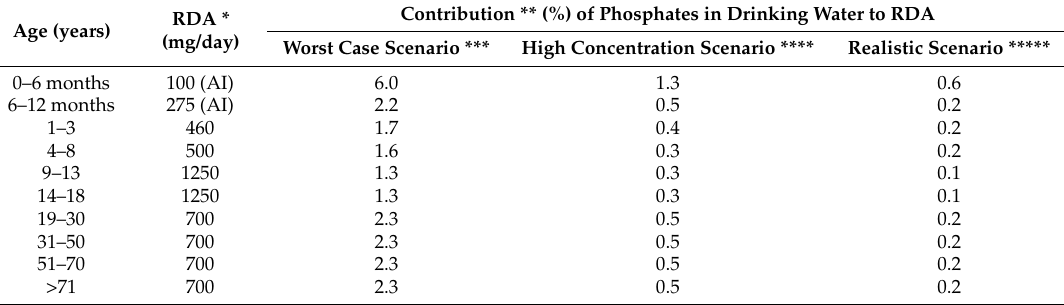
Table 2. Exposure assessment for phosphorus intake by drinking